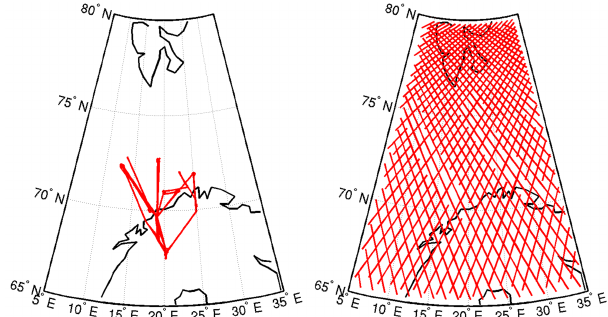
Figure 1. Aircraft trajectories for the measurement days listed in Table 1 (left) and positions of the CALIOP tracks from 27 March to 11 April